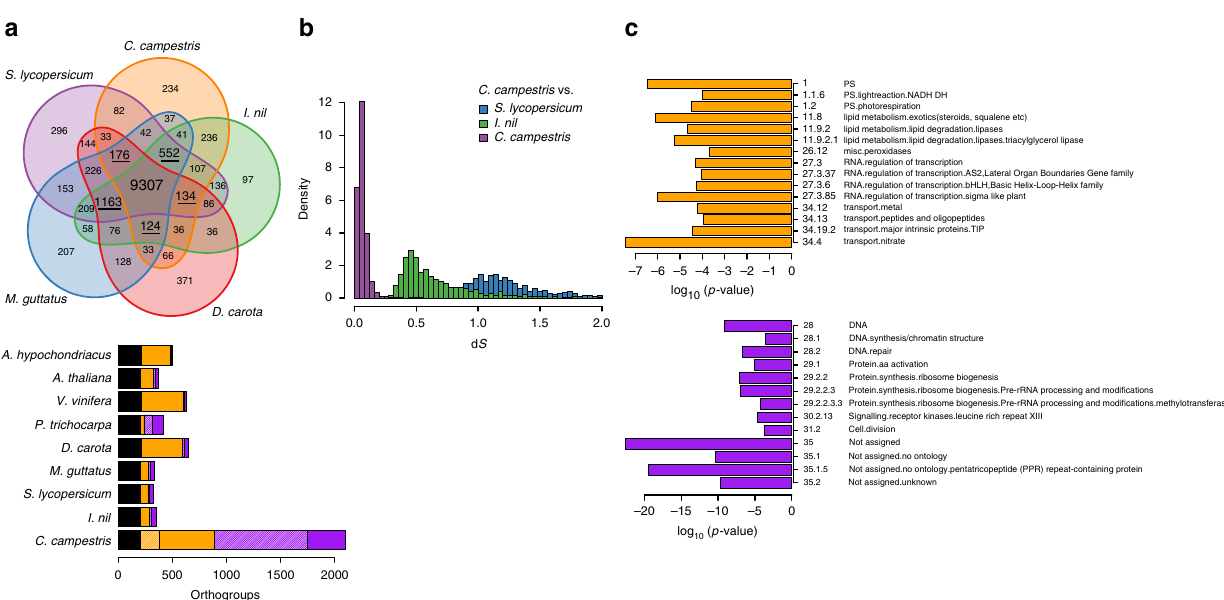
Fig. 3 Duplication and loss of genes in the C. campestris genome. a Overview over 14,626 asterid orthogroups from C. campestris , Ipomoea nil , Solanum lycopersicum , Mimulus guttatus, and Daucus carota . The Venn diagram shows the number of overlapping and exclusive orthogroups found in the fi ve species. The bar diagram below summarizes gene content in orthogroups in C. campestris and eight divergent dicot species. Indicated in black are orthogroups with exactly one member in each of these species (202 OGs). Orthogroups missing in the respective species only, but that are otherwise present in all species once (exactly 0:1, named:other species, striped) or more than once (ratio 0:1 or more, solid color) are shown in orange and are underlined in the Venn diagram. Duplicated orthogroups are de fi ned as having exactly 2:1 genes per species (striped purple) or as having a ratio of at least 2n:n with at least one gene in every species (solid purple). All above ratios are (named species):(other species). b Synonymous substitution rate (d S ) analysis. Density of d S rates for C. campestris paralogs are shown in purple, and for 1:1 orthologs with I. nil and S. lycopersicum in green and blue, respectively. c Functional enrichment analysis of lost and duplicated genes. MapMan categories for genes that are signi fi cantly enriched are depicted using the logarithmic values of their p values. The orange bars represent lost genes that are present in one or more copies in the eight other dicot species shown in a but are lost in C. campestris (ratio 0:1 or more). Similarly, purple bars represent categories signi fi cantly enriched for duplicated genes (at least 2 n : n